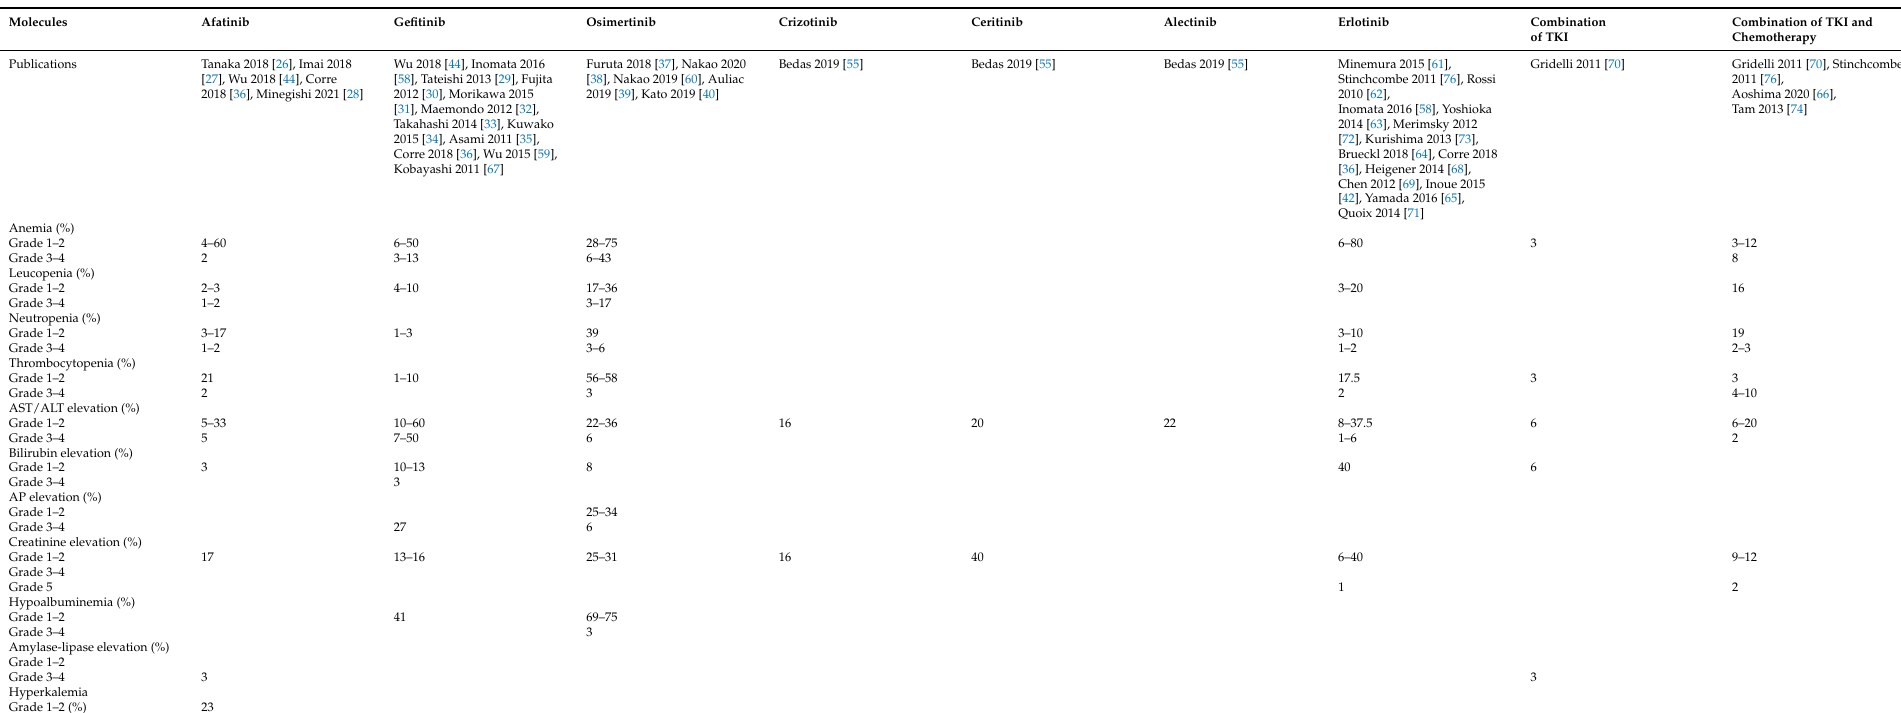
Table 4. Prevalence of hematological and biological toxicities according to targeted therapies in trials, cohorts, or trial subgroup post-hoc